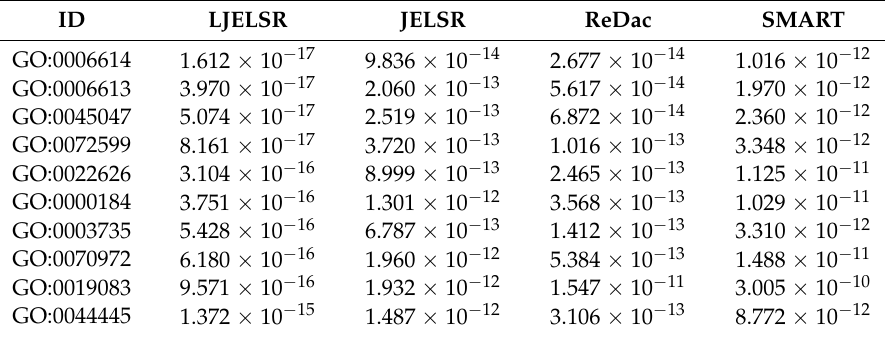
Table 4. The p -values of different methods for the colon dataset.